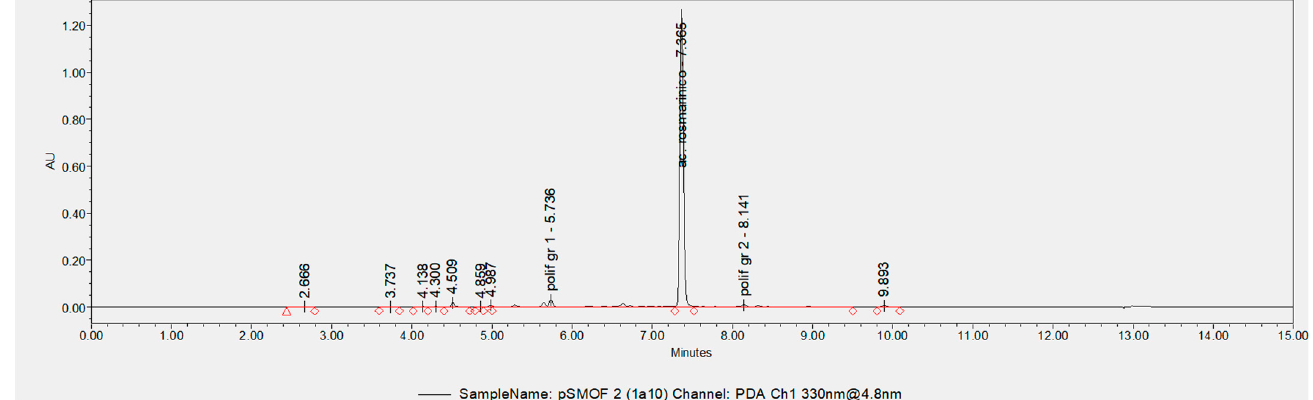
Figure 2. Chromatographic profile of the Melissa officinalis phytocomplex. The main peak at retention time of 7.3 min corresponds to rosmarinic acid.